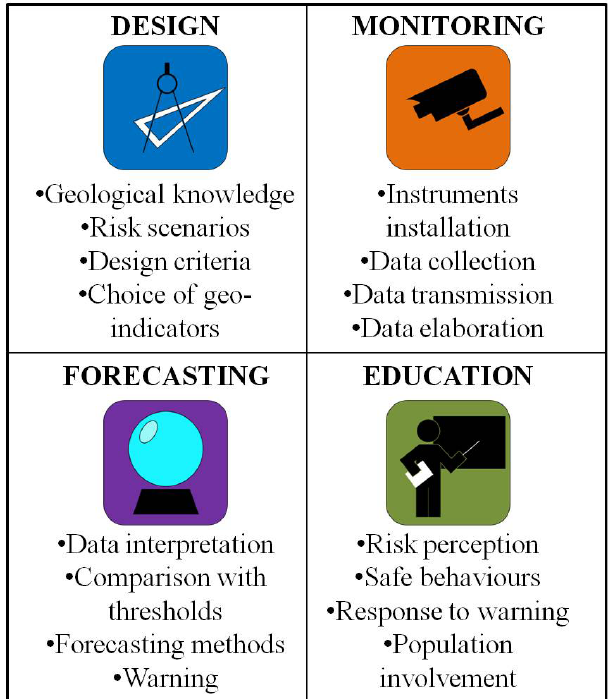
Fig. 1. Subdivision of a generic EWS in its four fundamental com-